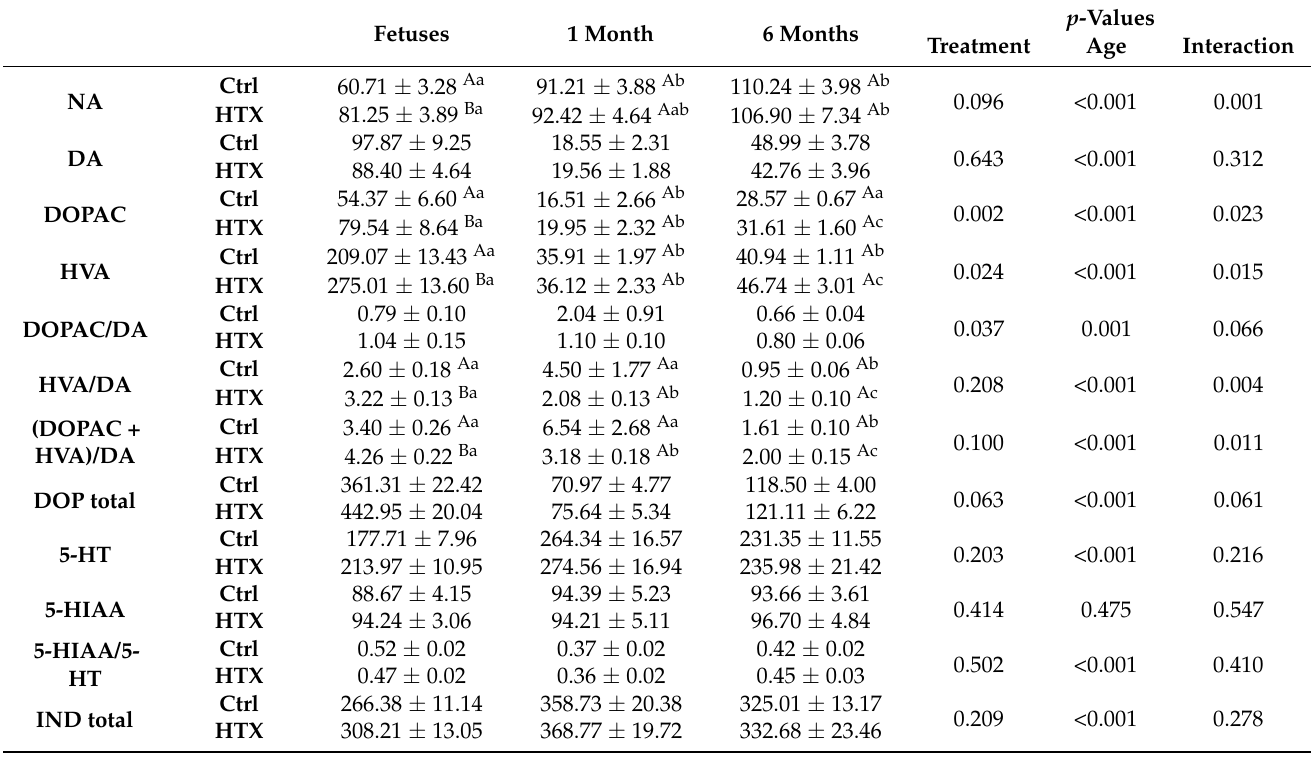
Table 2. Effects of the supplementation of the maternal diet without (Ctrl) or with HTX on the mean values of the concentration of neurotransmitters in the hippocampus of 100-day-old fetuses, and 1-month- and 6-month-old